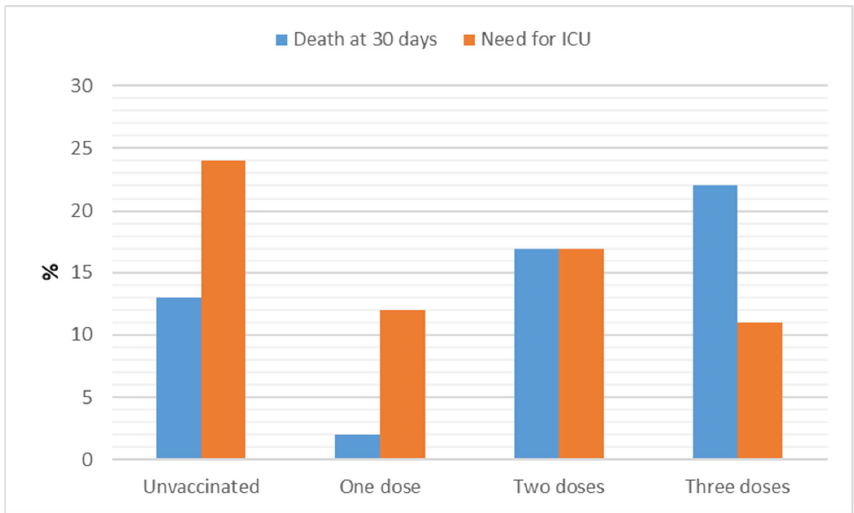
Figure 3. Need for intensive care unit (ICU) admission and all ‐ cause 30 ‐ day mortality by doses of vaccine received. p < 0.005 among groups considering ICU admission; p < 0.01 among groups